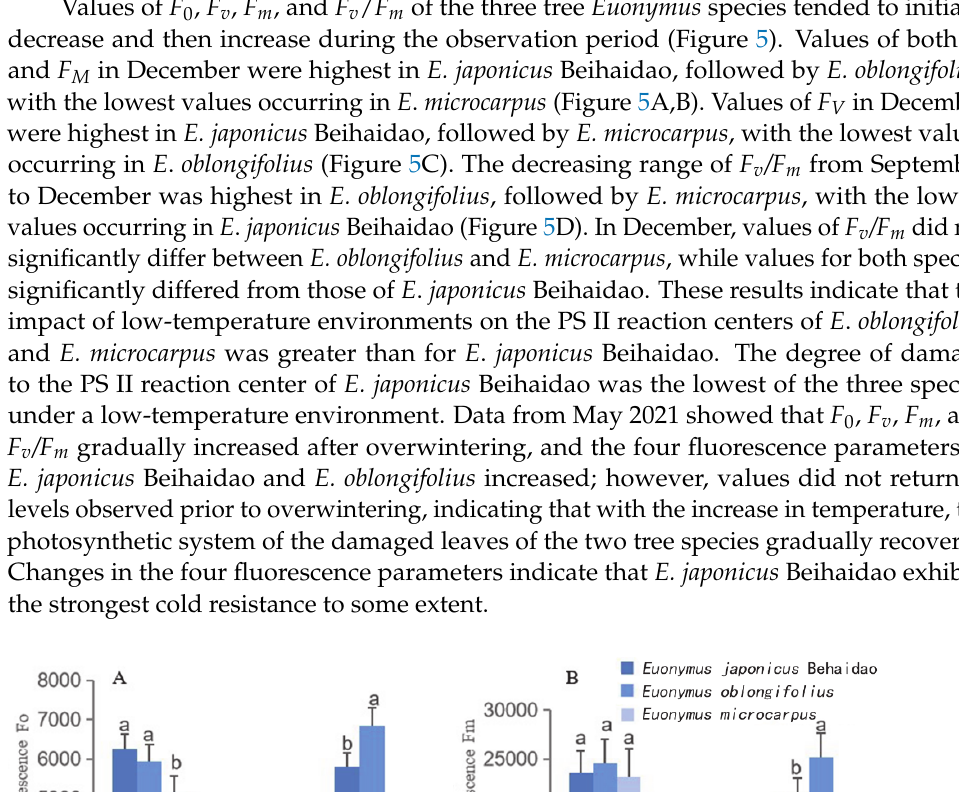
Figure 5. Changes in the chlorophyll fluorescence parameters in three Euonymus species. ( A ) initial fluorescence; ( B ) maximum fluorescence; ( C ) variable fluorescence; ( D ) the maximum photochemical efficiency; a and b represent significant differences. 3.2.4. Changes in Net Photosynthetic Rate The net photosynthetic rate of the three Euonymus species was lowest in December, with the highest values occurring in E. japonicus Beihaidao followed by E. oblongifolius , with the lowest values occurring in E. microcarpus (Figure 6). After low ‐ temperature stress, the chloroplast structure and thus the photosynthetic organs of the three species may have been damaged, resulting in the decline of photosynthetic capacity. With the gradual increase in temperature in the spring, the photosynthetic capacity of E. japonicus Beihaidao and E. oblongifolius gradually recovered; the net photosynthetic rate increased, and the photosynthetic capacity was higher than levels prior to overwintering. This response was more pronounced in E. japonicus Beihaidao than in E. oblongifolius . The results of variance analysis indicated that the net photosynthetic rate did not significantly differ between E. oblongifolius and E. microcarpus in either September or December. The net photosynthetic rate of E. japonicus Beihaidao was significantly higher than those of E. oblongifolius and E. microcarpus during each month, indicating that the photosynthetic capacity of E. japonicus Beihaidao was highest.